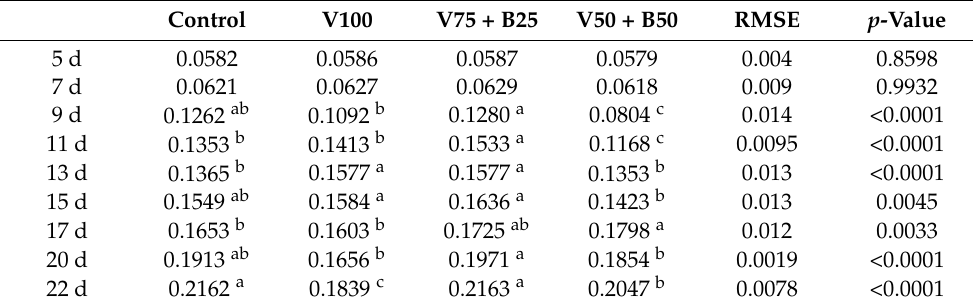
Table 2. Live weight (g) of black soldier fly larvae from 5 to 22 days of age.